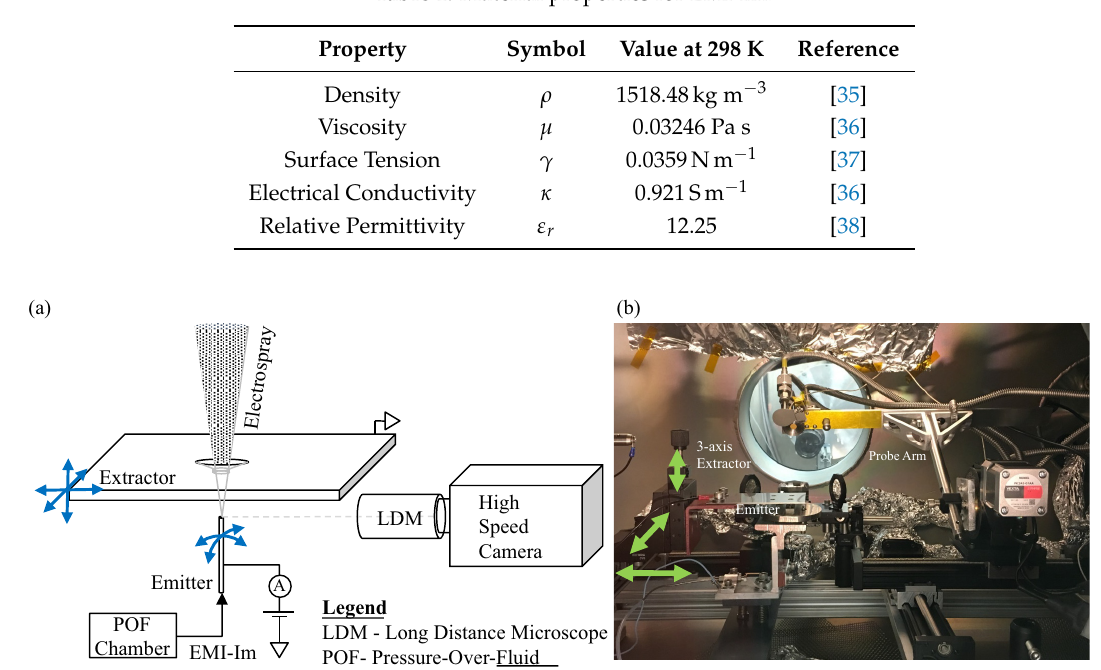
Figure 2. Highly Optimizable Apparatus for Groundbreaking Investigation of Electrosprays (HOAGIE), configured for the presented experiments. ( a ) Schematic of setup and diagnostics; ( b ) photograph of